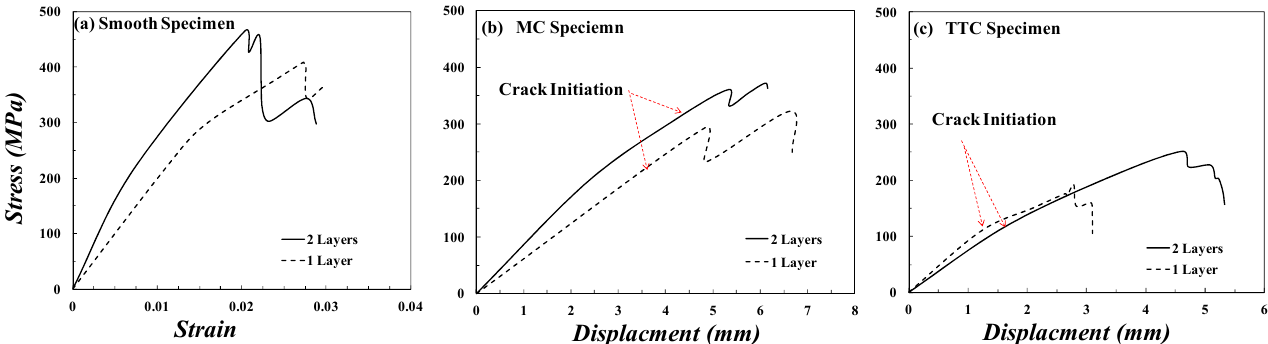
Figure 13. Specimens of ASTM D3039 made of GFRE with one layer and two layers: ( a ) Stress-Strain curve of the smooth specimen, and Stress-Displacement diagram of ( b ) MC specimen, and ( c ) TTC specimen.